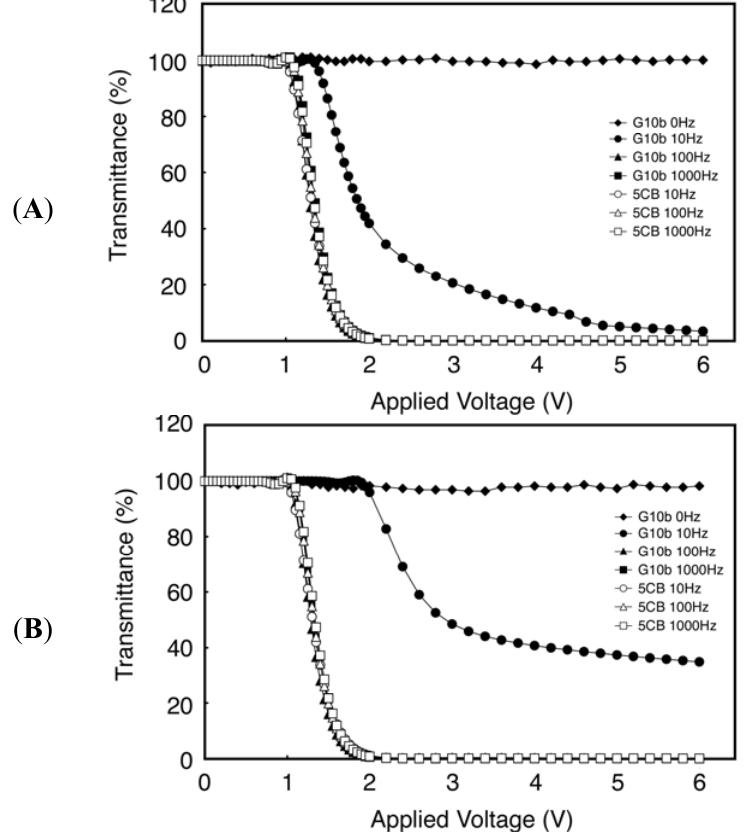
Figure 4. Electrooptic characteristics of LC cells. The frequency of the operating voltage is used as a parameter. Open dots indicate the experimental data from LC cell doped with ( A ) G10b (100 μ M) or ( B ) G10b (500 μ M), and filled dots indicate that from LC cell with